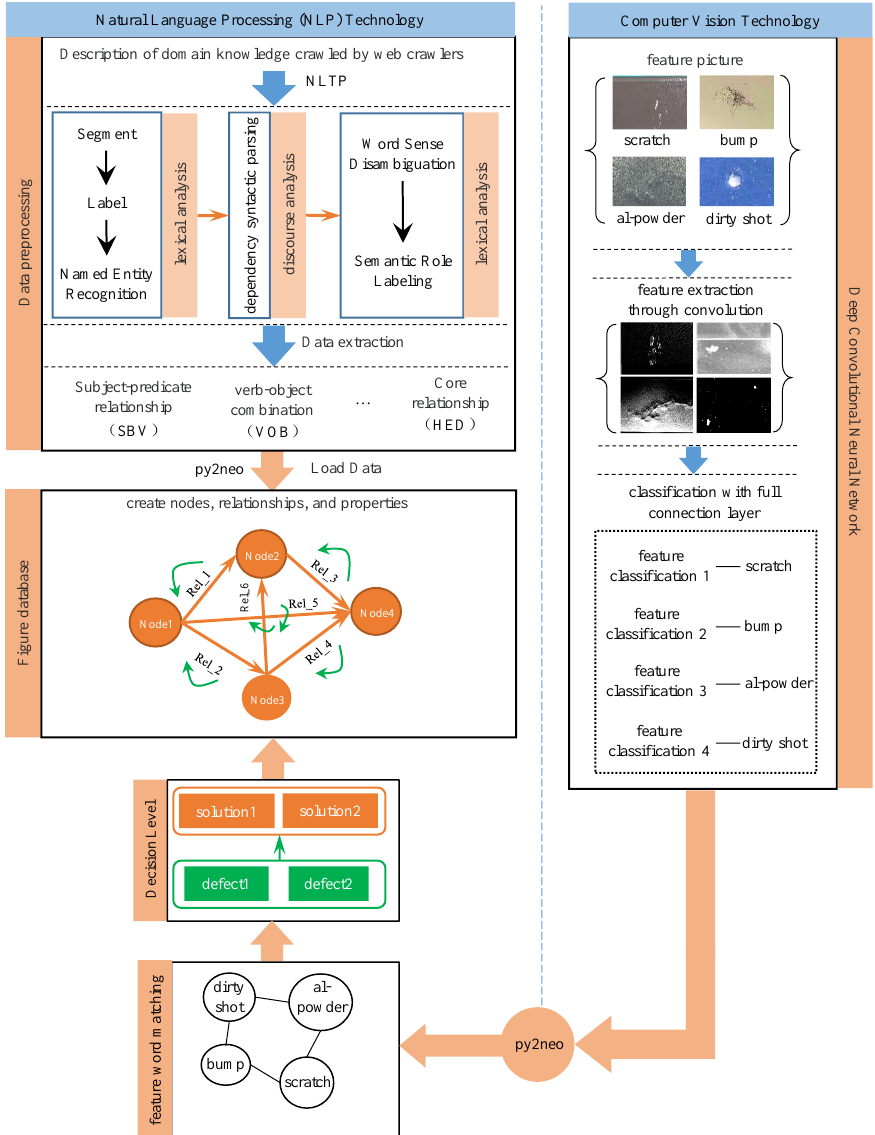
Figure 1. Fusion knowledge representation architecture based on computer vision and natural language technology.